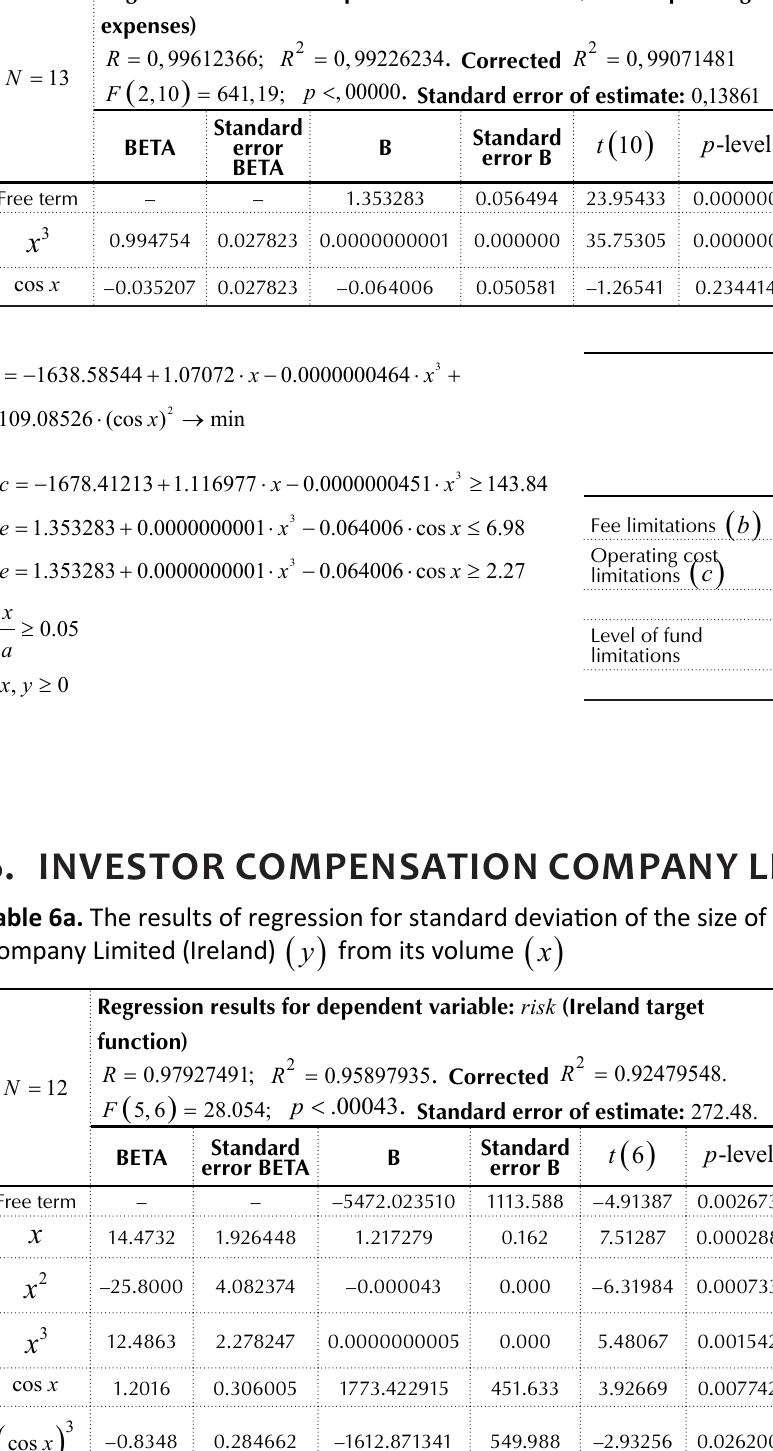
Table 5c. The results of regression for operating costs of The Funds of the Guarantee for Dépôts et de Résolution (FGDR) (France) ( ) e from the fund’s volume ( ) x Regression results for dependent variable: costs (France operating 13 N =